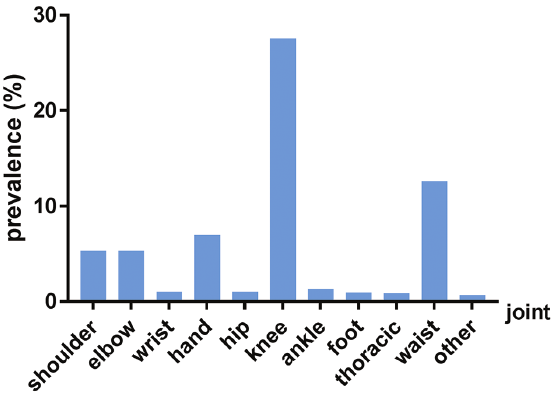
Figure 1. The distribution type of OA in Chinese adults aged 50 years or older.